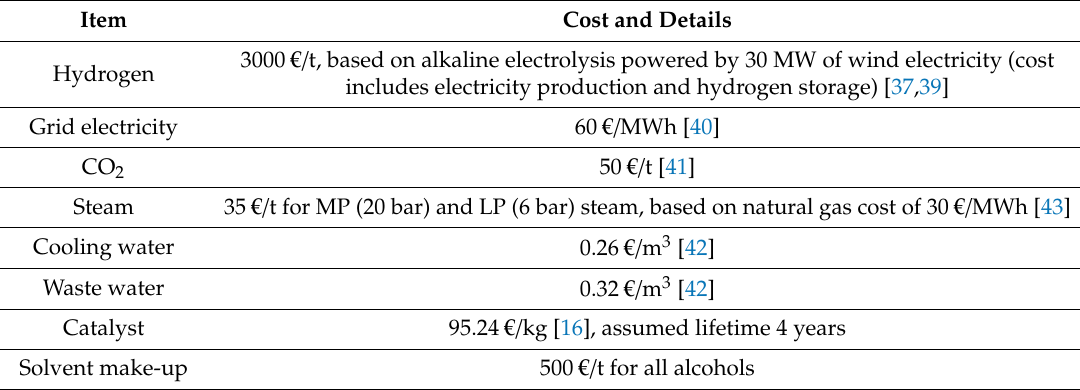
Table 2. Variable costs considered in the analysis. MP, medium-pressure; LP,